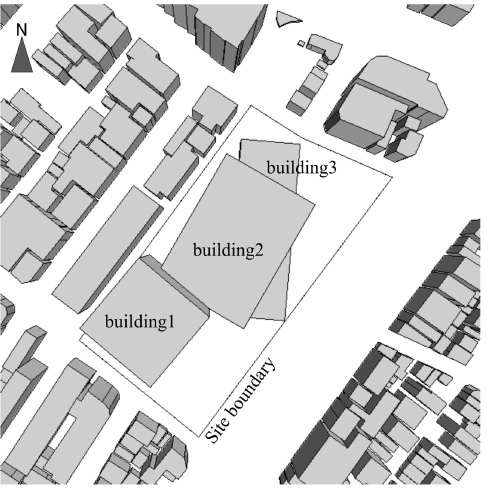
Figure 9. Building configuration generated in the last